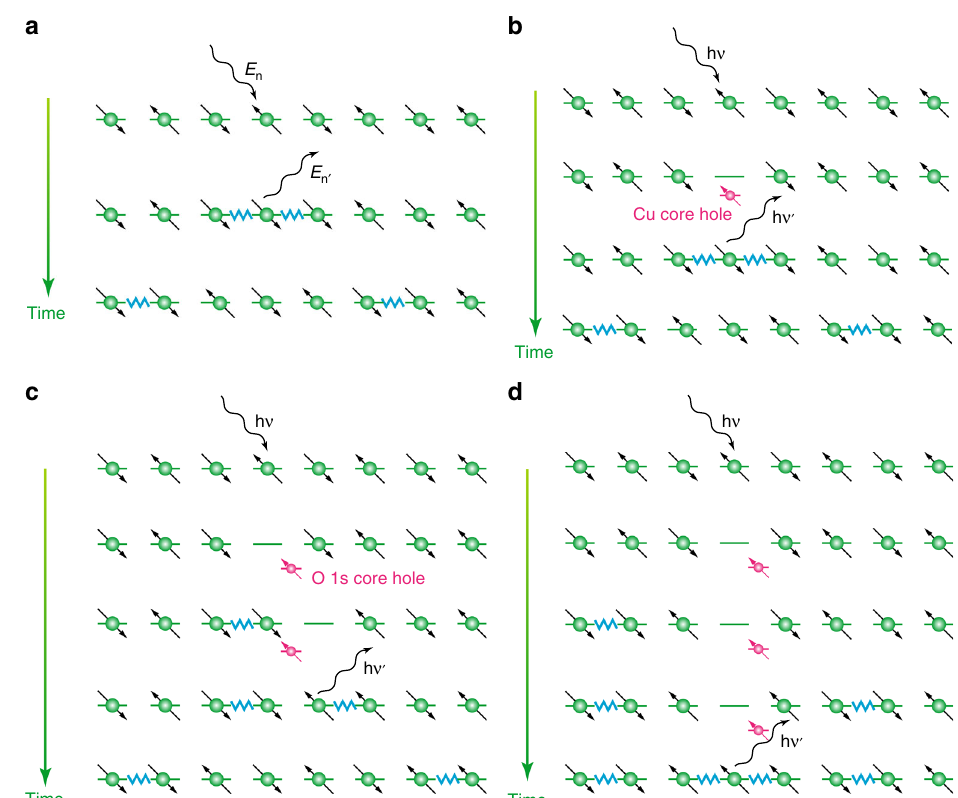
Fig. 3 An illustration of various spin excitations through elementary spin- fl ips. a The Δ S tot = 1 direct spin- fl ip process that can occur in an inelastic neutron scattering experiment, which primarily decays into two-spinon excitations that are visualized as domain walls in the antiferromagnetic (AFM) background 5 . b The same Δ S tot = 1 spin- fl ip process in RIXS, which is accessible in materials with strong spin – orbit coupling in the core level 32 . c The indirect double spin- fl ip process at the oxygen K -edge, which occurs via the multi-orbital hopping processes sketched in Fig. 1e. This process generates a nearest-neighbour double spin fl ip, which predominantly decays into a two-spinon excitation 22,38 . d A second-order process at the oxygen K -edge that produces four-spinon excitations. Here, the absence of the spin in the AFM chain allows double spin- fl ips to occur on the sites adjacent to the missing spin. These double spin- fl ips generate spinon excitations away from the site where the core hole is created. The subsequent decay of the core hole then produces two additional spinons in its vicinity. This process requires a long-lived core-hole to allow for suf fi cient time to generate the two double spin- fl ips before the core-hole decay